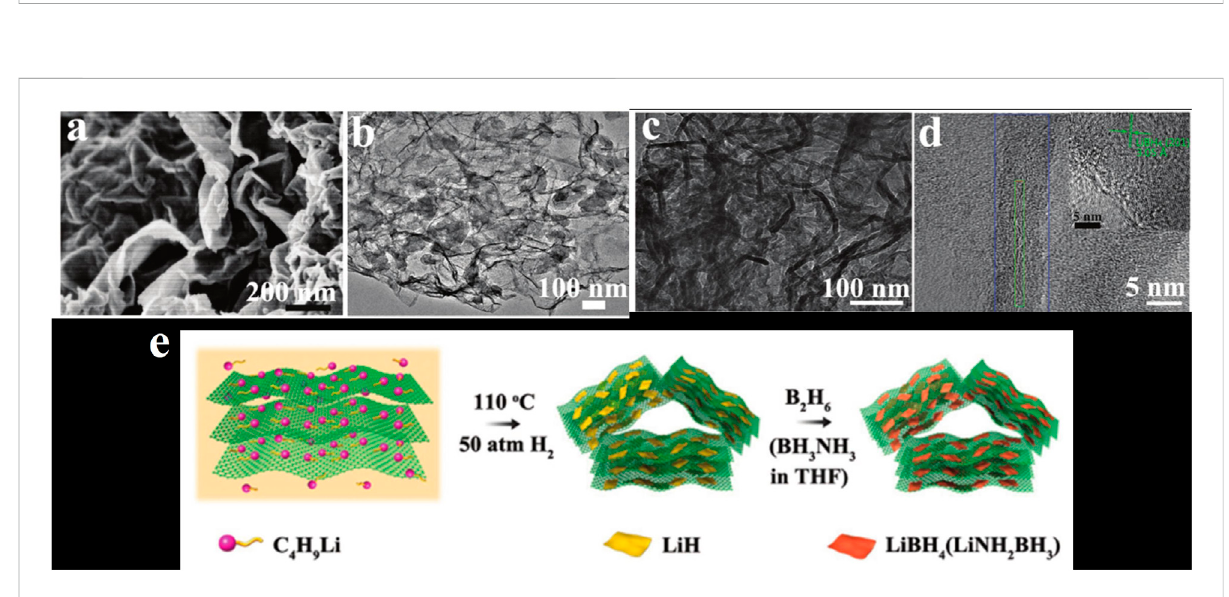
FIGURE 4 (A) SEM image of LiBH 4 @G. (B – D) TEM image of LiBH 4 @G. (E) Flow chart of preparation of LiH@G (Xia et al.,